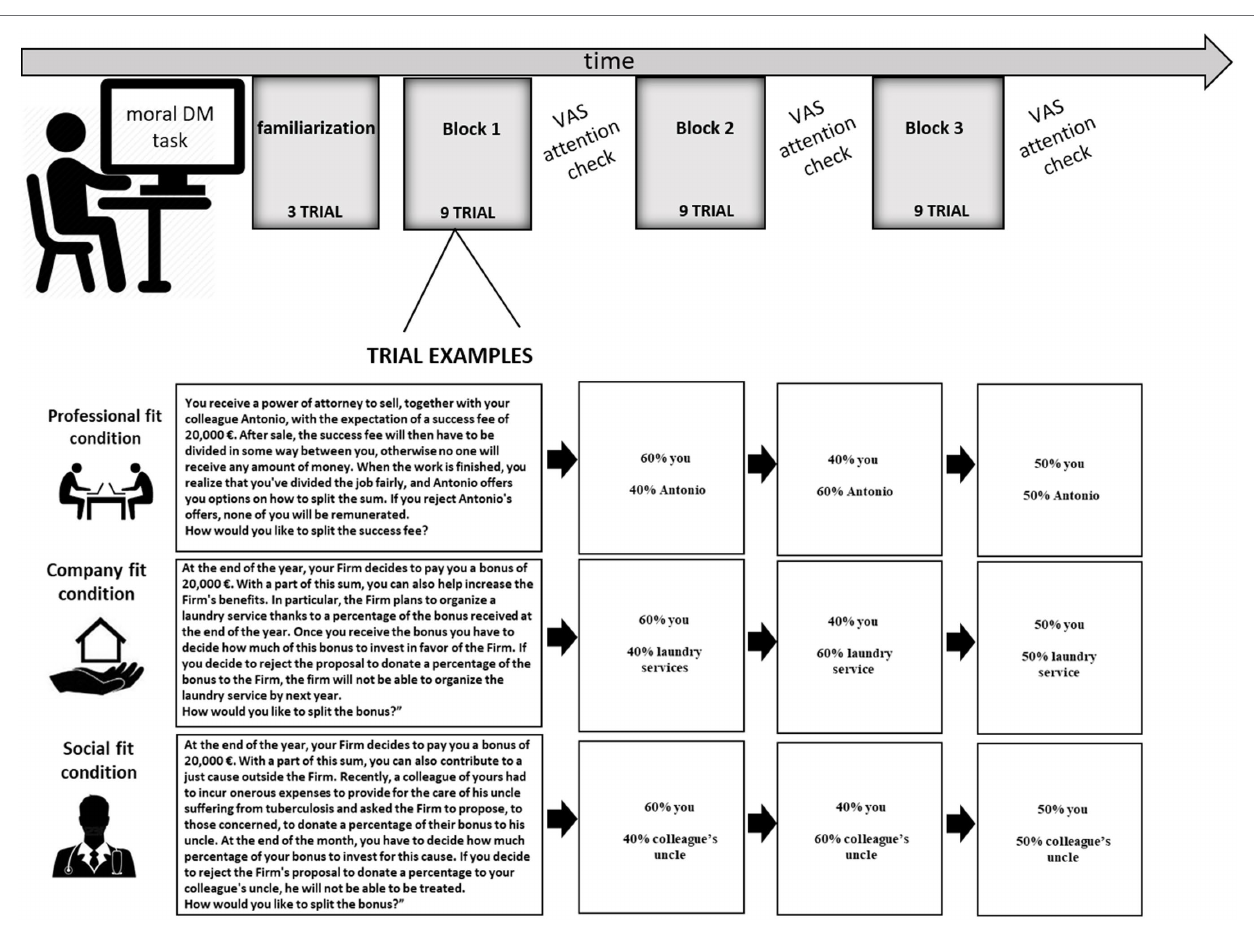
FIGURE 1 | The research experimental procedure and sample